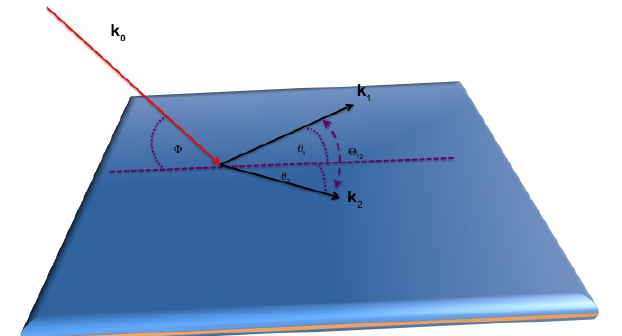
Figure 1. The incoming projectile has momentum k 0 and energy E 0 , and it comes in at an angle Φ with respect to the plane in which the two final state particles are detected at angles θ 1 , θ 2 with respect to the projection of the incoming direction on their plane. Φ = 0 ◦ corresponds to coplanar geometry, Φ = 90 ◦ to perpendicular plane geometry. Θ 12 is the angle between the two detected